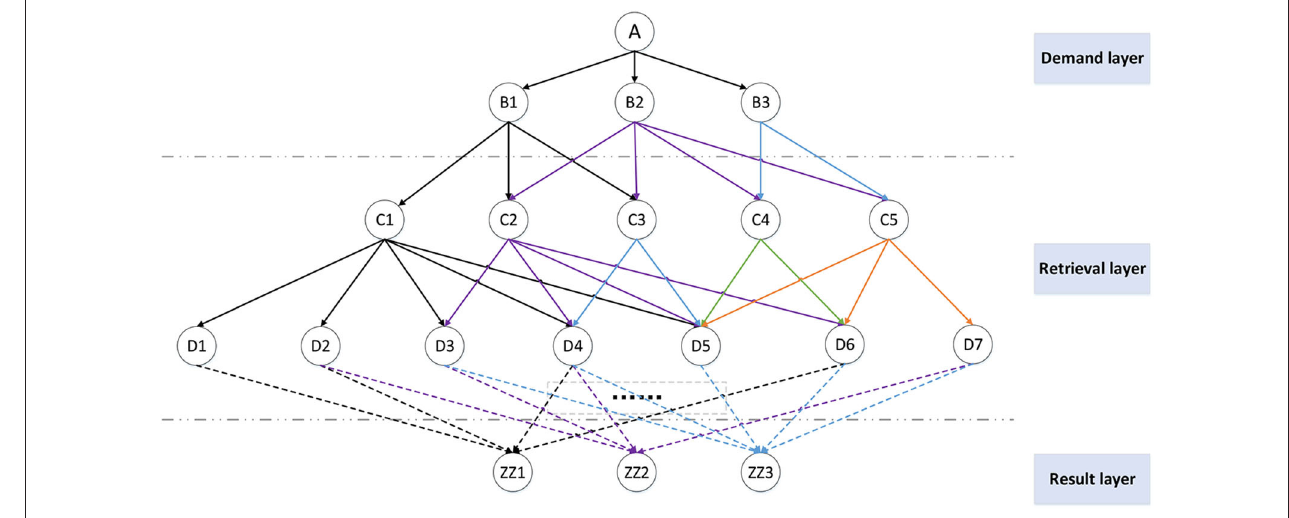
FIGURE 4 | Hierarchical structure of the M-3DQKG model.